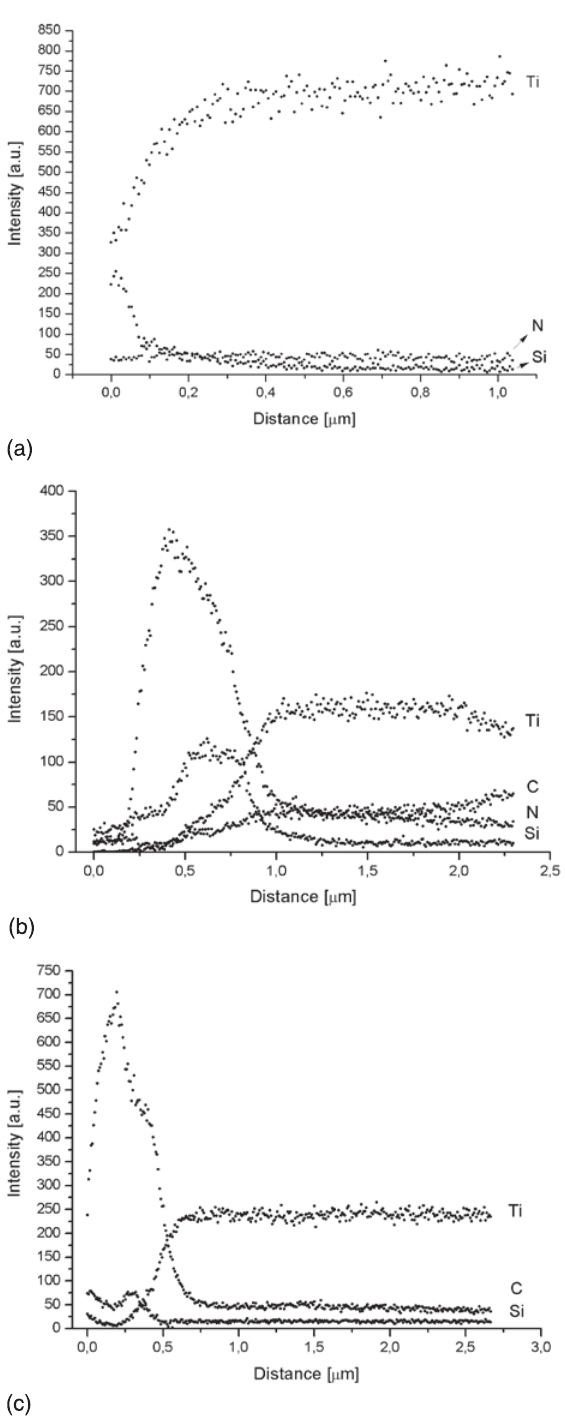
Fig. 3: SEM analysis of elements along the line determined for systems: a) Si x N y (H)/alloy, b) SiC x N y (H)/alloy, c) SiC x